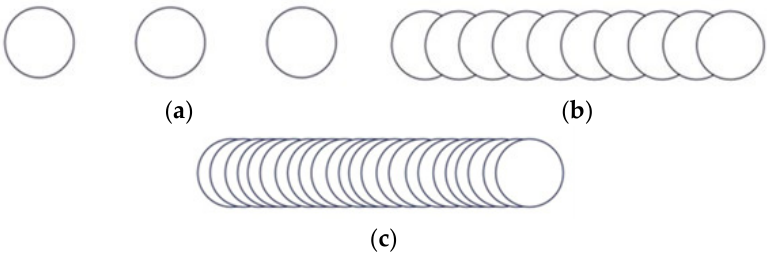
Figure 5. Representation of laser spot overlapping 0% ( a ), 50% ( b ) and 90% ( c ).